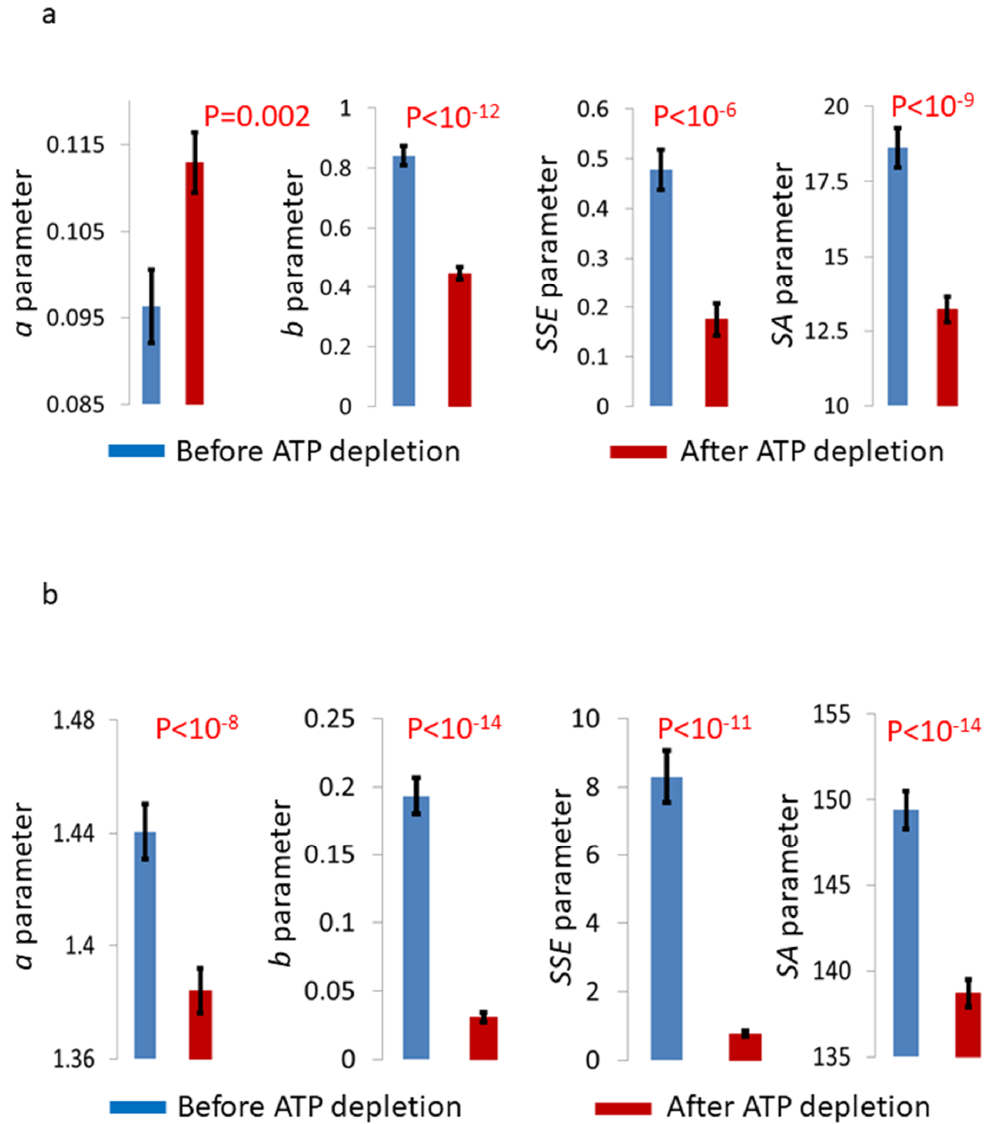
Figure 6. A comparison of average GLIE and SICS fluctuations analysis results in Jurkat cells (n = 34) before and after ATP depletion. Average power-fit and ASD parameters results in the cells before and after ATP depletion following SICS fluctuation analysis ( a ) or GLIE fluctuation analysis ( b ). Error bars in panels a and b are SEM, and p -values are presented in the corresponding panels. As previously suggested, PSD or ASD analyses can serve for characterizing intracellular dynamics, and relate to the Mean Squared Displacement ( MSD ) equation; (cid:1839)(cid:1845)(cid:1830) = (cid:1837) (cid:3080) ∆(cid:1872) (cid:3080) , where (cid:1837) (cid:3080) represents the diffusion coefficient, ∆(cid:1872) represents the time lag and (cid:2009) represents the power of diffusion [20]. Specifically, the a parameter is related to K α —the diffusion coefficient; the b parameter is related to α —the power of the diffusion. Like α , the parameter b also increases by introducing mechanical work to the cell and a break in ergodicity. The SSE parameter also increases by adding mechanical work and a break in ergodicity. The SA parameter relates to the general dynamics in the measured system. As expected according to these relations, we observe higher parameter values obtained in active cells that produce significant amount of mechanical work in comparison to cells after ATP depletion, in which no mechanical work is produced.